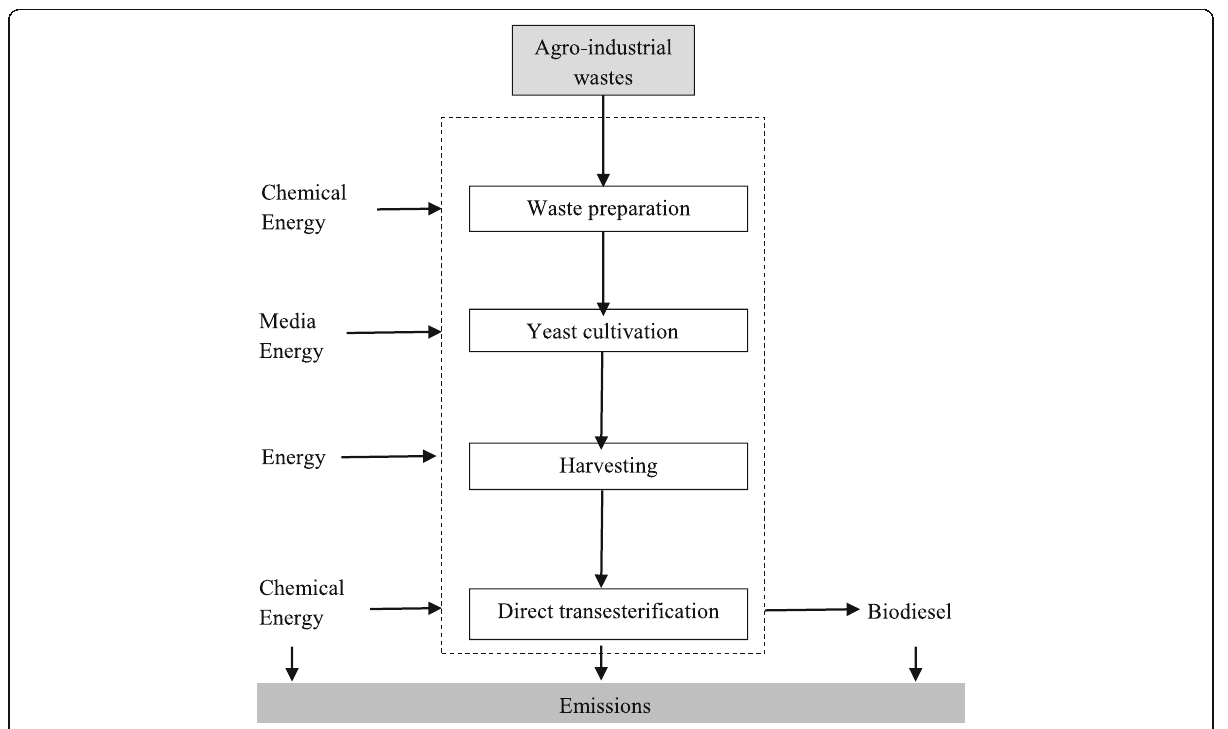
Fig. 1 Life cycle system boundary of the lipid production by oleaginous yeasts and subsequent biodiesel production through direct